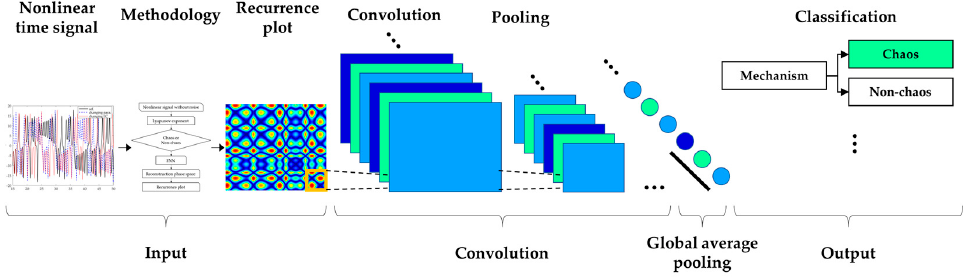
Figure 6. Flow diagram of CNN model.